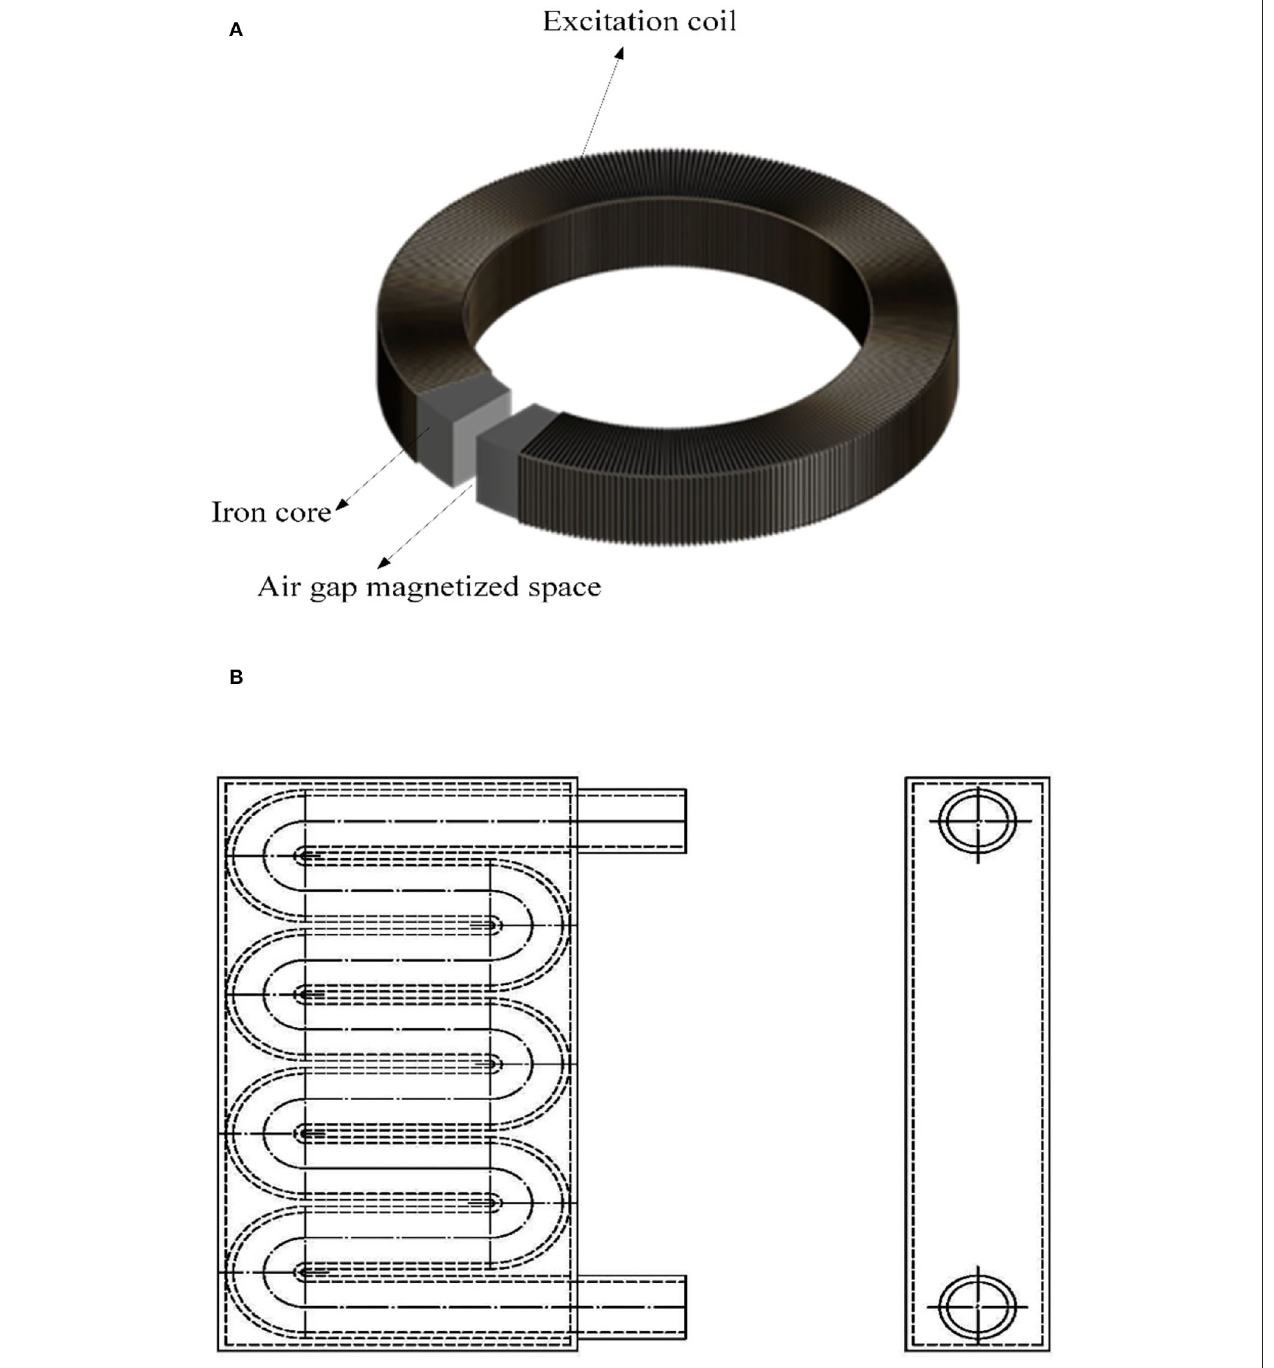
FIGURE 1 | (A) Liquid magnetizer structure. (B) Liquid magnetized space